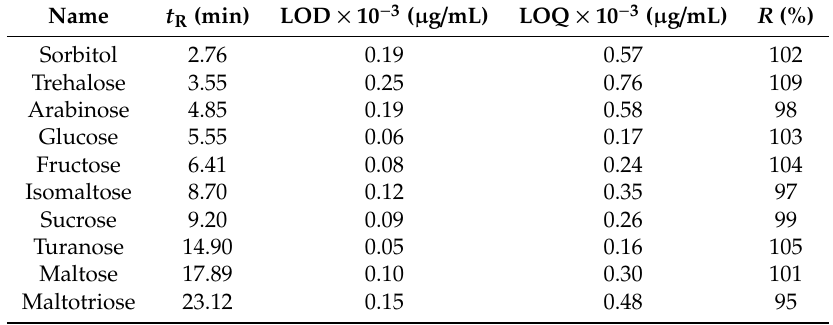
Table 1. Validation parameters: Retention time ( t R ), limit of detection (LOD), limit of quantification (LOQ), and recovery ( R ,